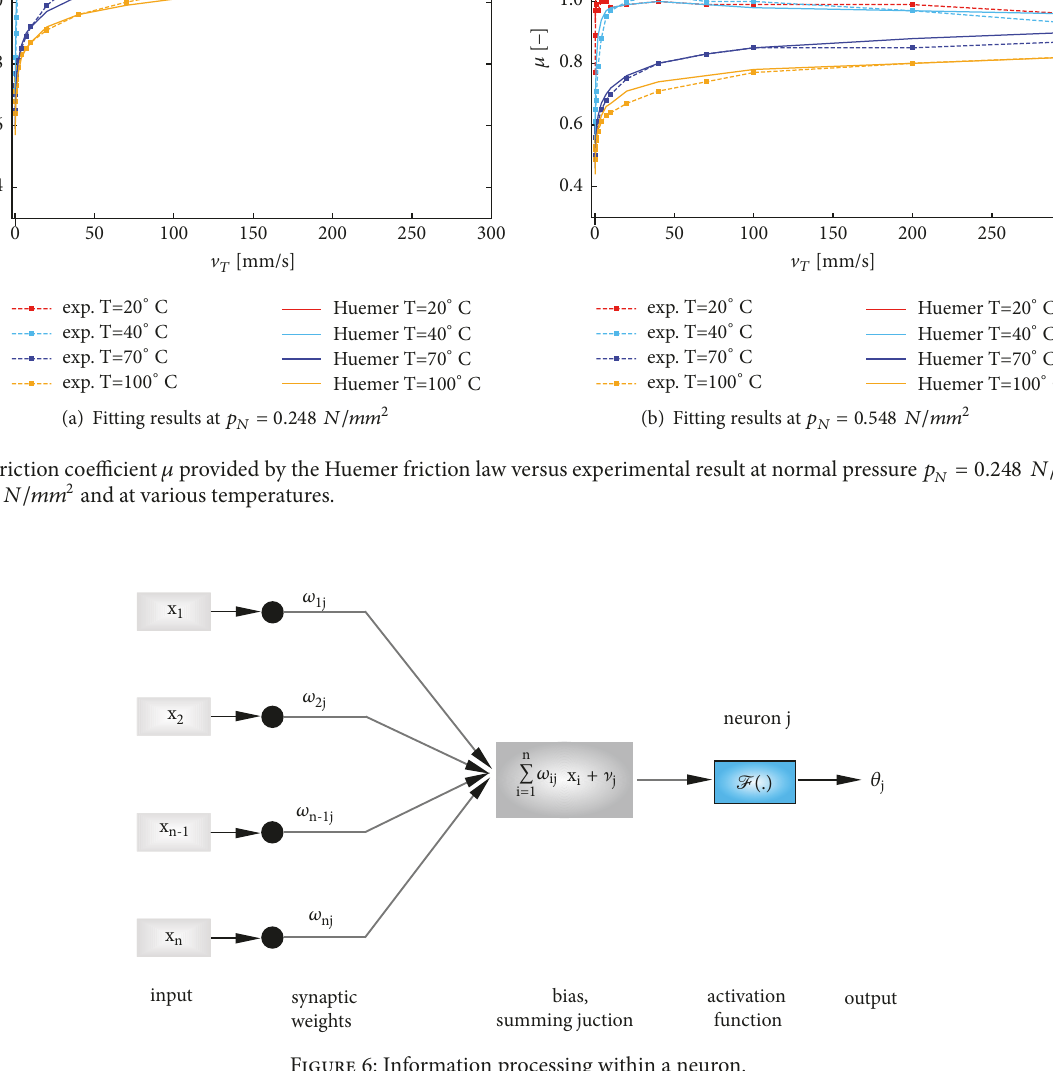
Figure 6: Information processing within a